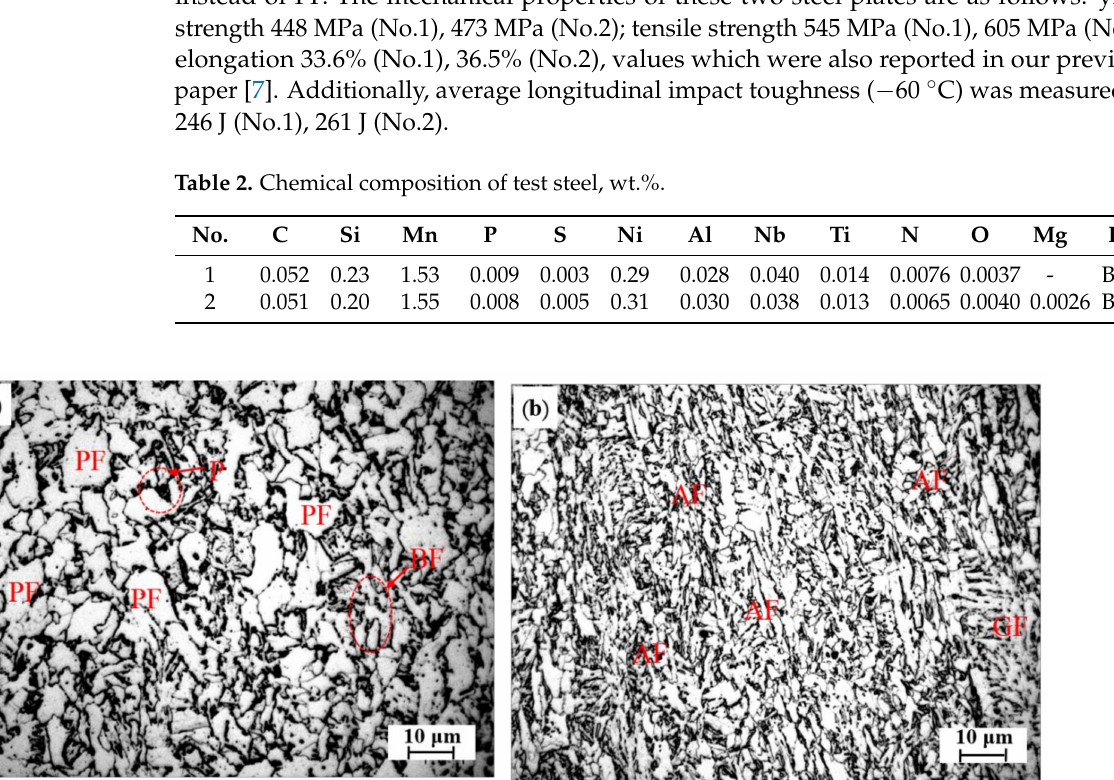
Figure 1. Optical micrographs of the rolled microstructure of steels: ( a ) No.1; ( b ) No.2, and the PF is polygonal ferrite; AF is acicular ferrite; BF is bainitic ferrite; GF is granular bainite